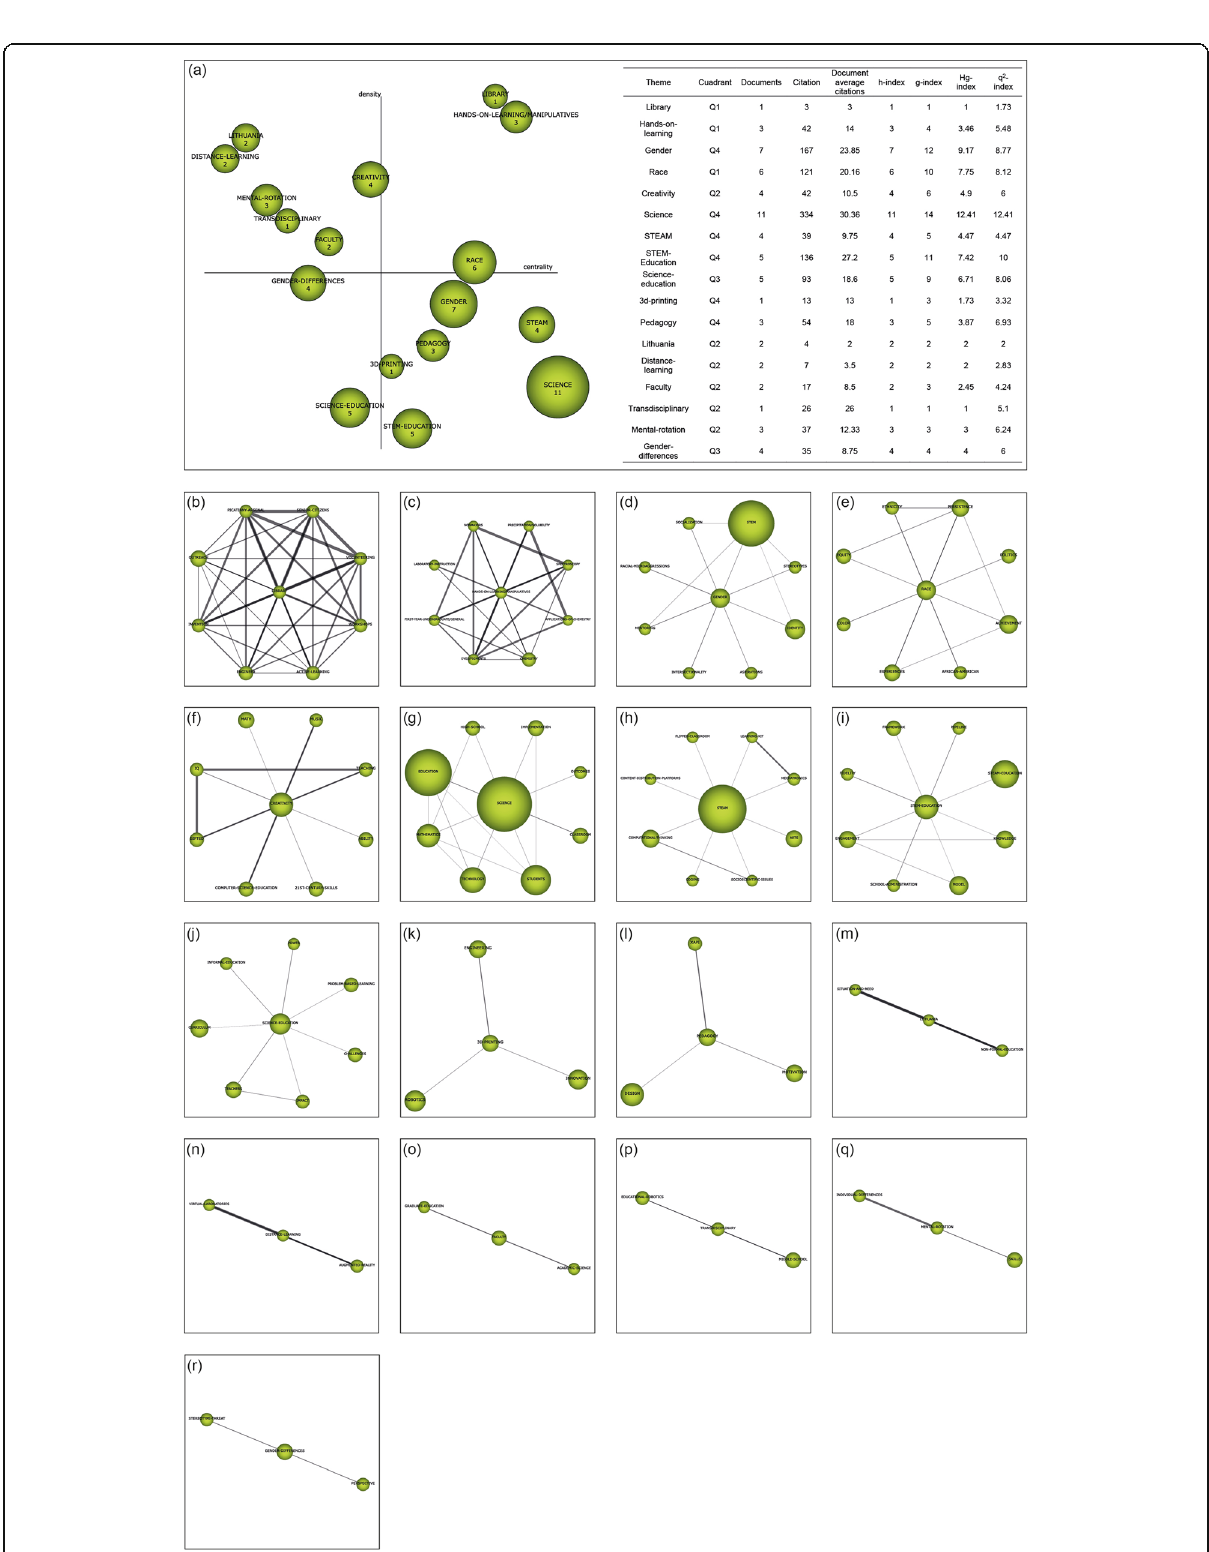
Fig. 6 Strategic diagram of the 2016 to 2018 period. Note . a Strategic diagram (h-index) and performance from 2016 to 2018. Themes include b “ library, ” c “ hands-on-learning/manipulatives, ” d “ gender, ” e “ race, ” f “ creativity, ” g “ science, ” h “ STEAM, ” i “ STEM-Education, ” j “ Science-education, ” k “ 3d-printing, ” l “ pedagogy, ” m “ Lithuania, ” n “ distance-learning, ” o “ faculty, ” p “ transdisciplinary, ” q “ mental-rotation, ” and r “ gender-differences